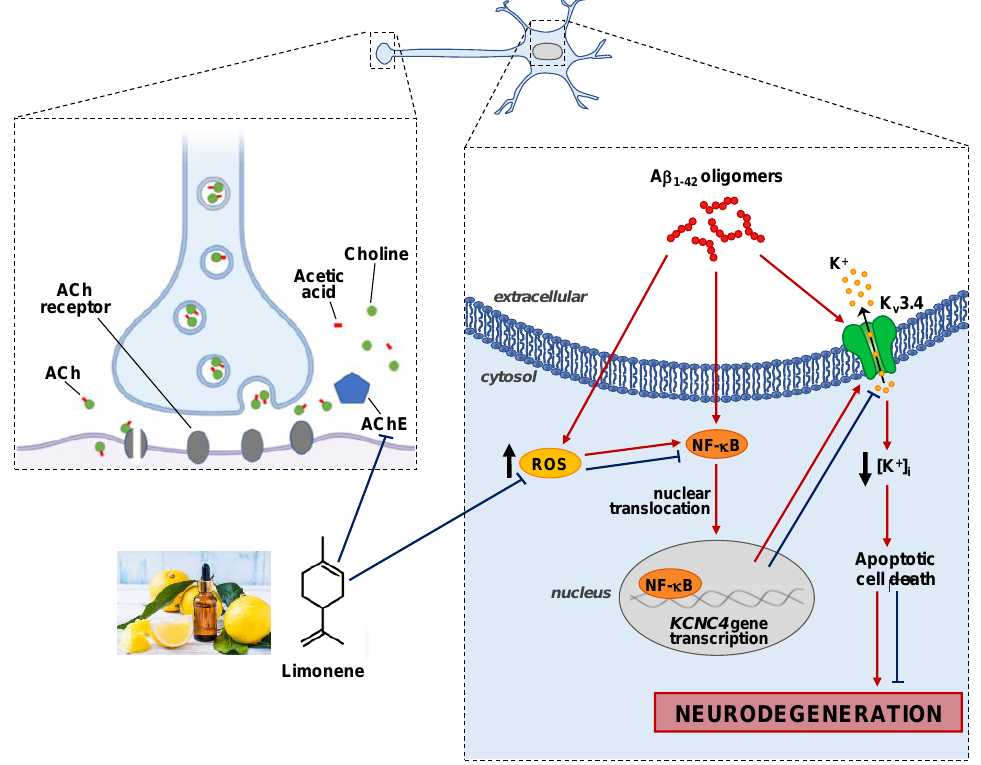
Scheme 1. Scheme of the putative mechanism of limonene action in cortical neurons exposed to Aβ 1-42 oligomers. A β 1-42